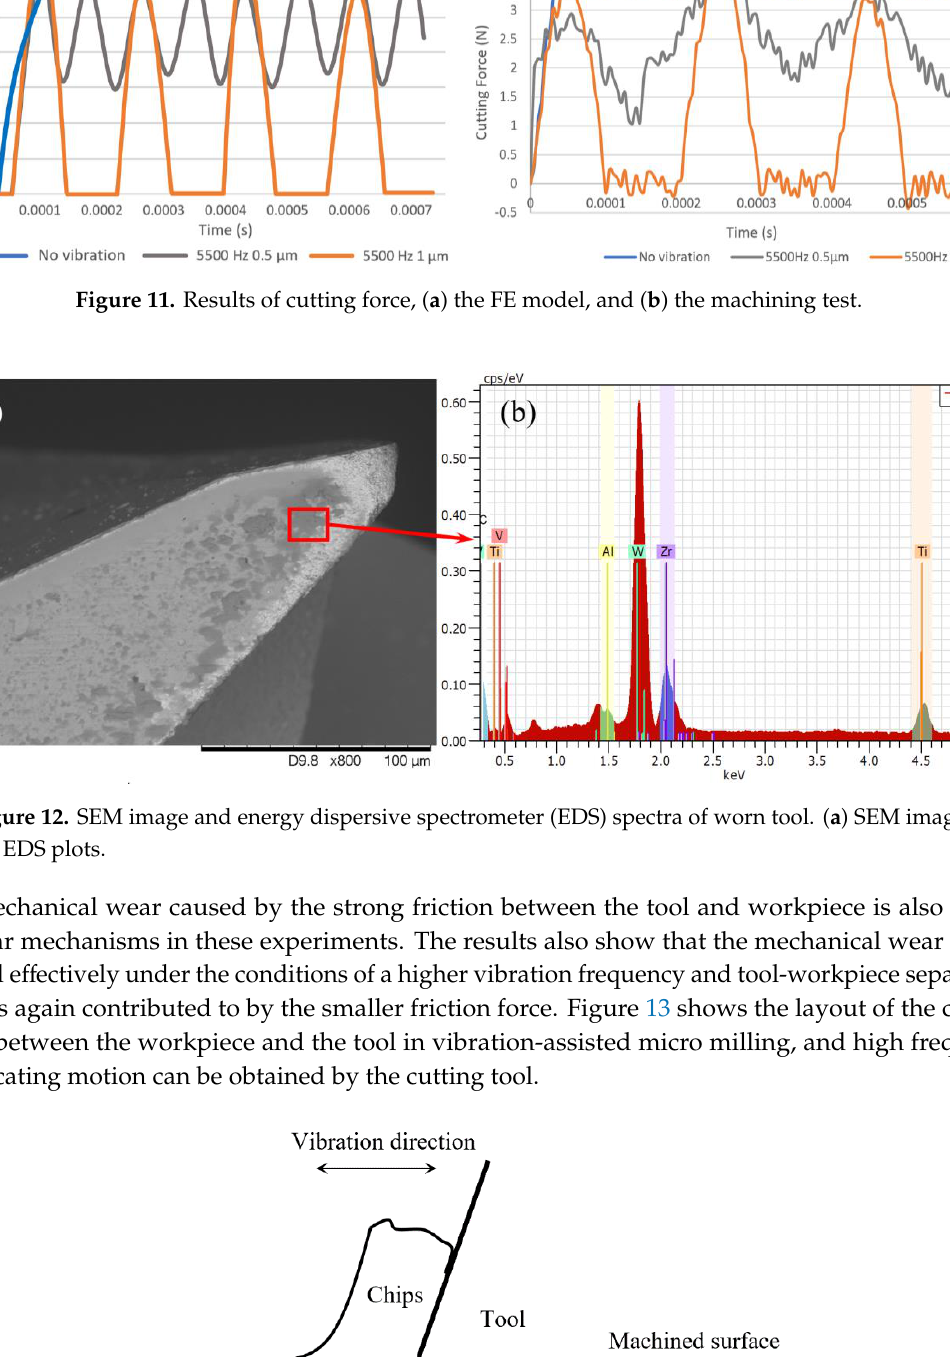
Figure 13. Layout of contact length between the workpiece and the tool in vibration-assisted micro milling.